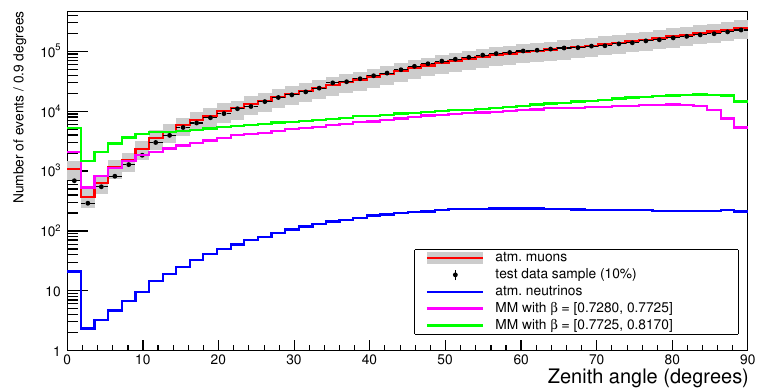
Figure 3 . Reconstructed zenith angle for atmospheric muons (red histogram) with an uncertainty band of 35% ((cid:12)lled in gray), atmospheric neutrinos (blue histogram) and data (points with error bars). For comparison, the distributions of the reconstructed zenith angle for MMs simulated in the velocity ranges [0 : 7280 ; 0 : 7725] (magenta histogram) and [0 : 7725 ; 0 : 8170] (green histograms) are also shown. The peak at zenith = 0 (cid:14) represents wrongly reconstructed